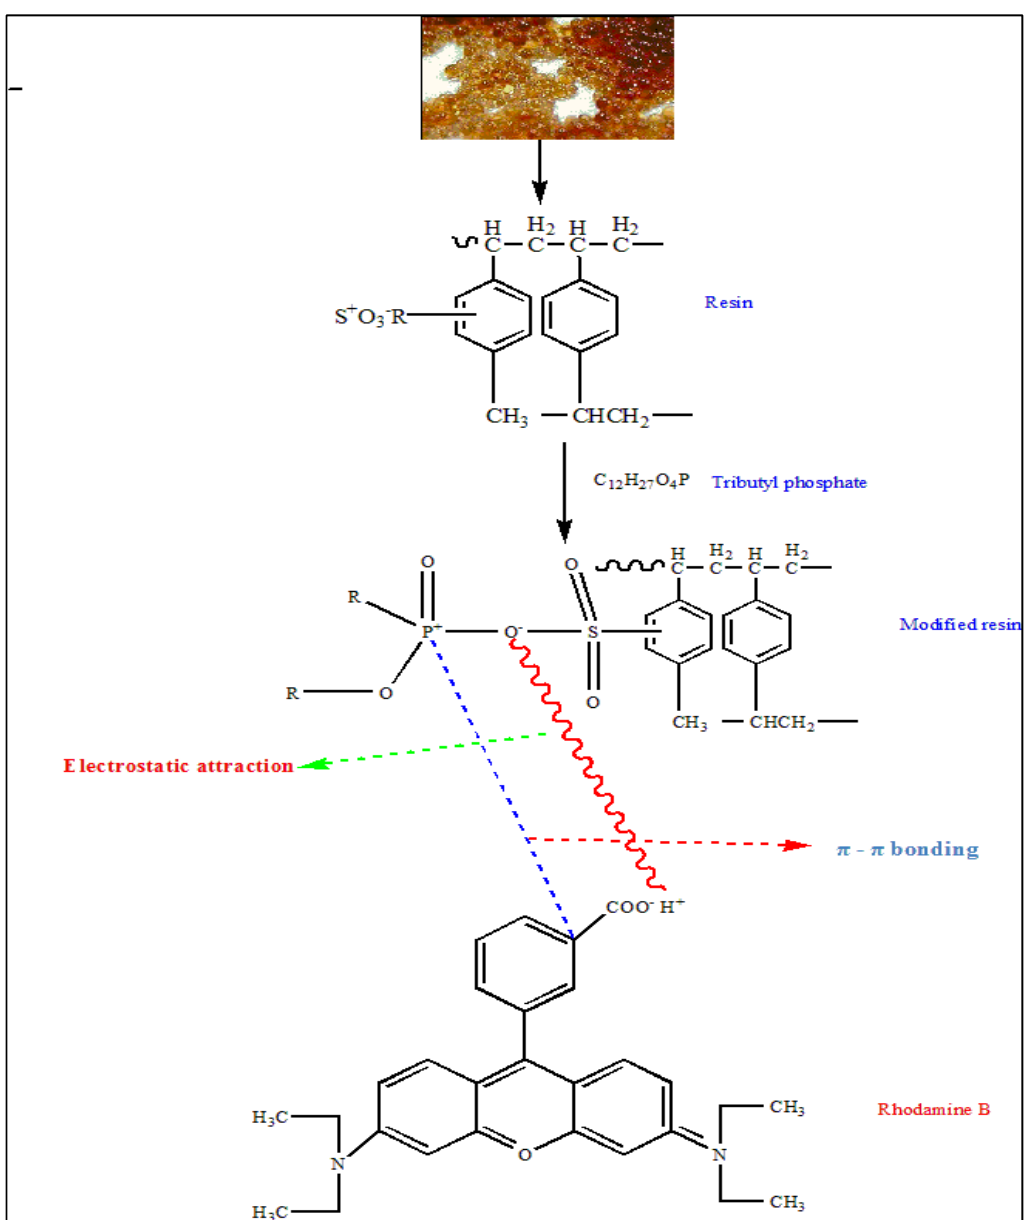
Figure 4. Schematic representation of SIR production and RhB adsorption mechanism on SIR.